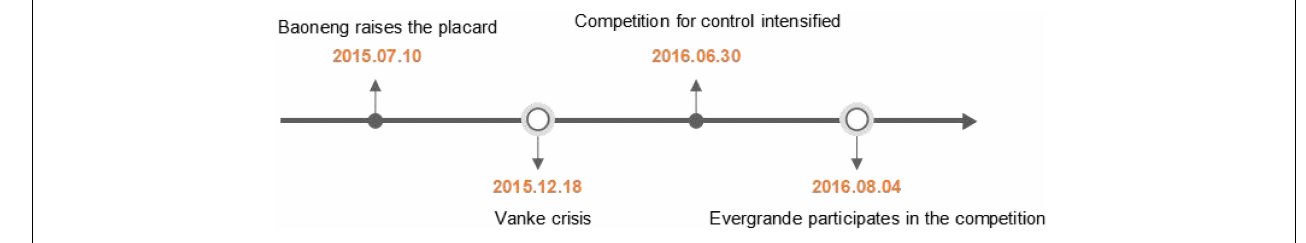
FIGURE 1 | Timeline of the Vanke equity